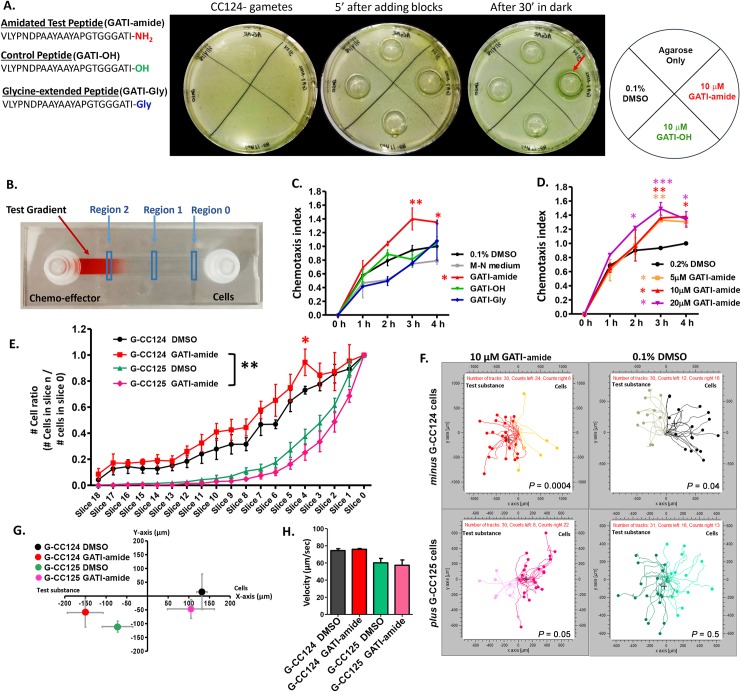
GATI-amide acts as a chemotactic modulator for C. reinhardtii gametes.A. Agarose block assay. CC124 minus gametes were uniformly spread on the surface of a Petri dish containing 1% agar in M-N medium. Agarose blocks containing 10 μM GATI-amide, 10 μM GATI-OH, M-N medium, or M-N medium containing 0.1% DMSO were placed onto the Petri dish; after 30 minutes in the dark, minus gametes had accumulated around the agarose block containing GATI-amide (red arrow). Similar results were obtained in three independent experiments. B. Microfluidic chemotaxis assay. Microfluidic channel slides were used for chemoattractant gradient formation. An image of a gradient of red food dye is shown. For each treatment, the number of cells in regions 0, I, and 2 were counted over time. C. Chemotaxis assay of minus gametes in microchannel slide. The chemotaxis index (CI) was measured over a period of 4 hours in response to 10 μM GATI-amide, GATI-OH, GATI-Gly, M-N medium, and vehicle control. The CI in the presence of GATI-amide was significantly higher at 3 hours (**P < 0.01) and 4 hours (*P < 0.05) compared to 0.1% DMSO. D. Dose dependence of the response of minus gametes to GATI-amide. A 4-hour incubation period was used; 0.2% DMSO was used as the vehicle control to accommodate the use of 20 μM peptide. The CI of 5 μM GATI-amide was significantly higher than the control at 3 hours (**P < 0.01); for 10 μM GATI-amide, the CI was significantly higher at 3 hours (**P < 0.01) and 4 hours (*P < 0.05), while for 20 μM GATI-amide it was significantly higher at 2 hours (*P < 0.05), 3 hours (***P < 0.01), and 4 hours (*P < 0.05). The only CI to ever exceed 1.00 was for GATI-amide. E. Chemotactic response. The response of minus and plus gametes to 10 μM GATI-amide and 0.1% DMSO. The number of cells for each treatment was counted along the entire channel length, and the ratio of the number of cells in each slice/number of cells in slice 0 (nslice X/nslice 0) was plotted for the 4-hour time point. The response of gametic CC124 cells to GATI-amide was significantly (**P < 0.001) different from gametic CC125 cells. Data are the average of three independent experiments ± SEM. F. Trajectory plots. Plots are shown for minus and plus gametes. Data are representative of three independent experiments; all plots shown are from one experiment. G. Population response. The center of mass was calculated for each population from trajectory plots like those shown in F. Results are the average of three independent experiments ± SEM. H. Motile behavior. The swimming velocities of minus and plus gametes were not altered by the presence of the amidated peptide. Results are the average of three independent experiments ± SEM. One-way and two-way ANOVAs were used as appropriate. The underlying numeric data for this figure can be found in S1 Data. GATI-amide, VLYPNDPAAYAAYAPGTGGGATI-amide; M-N medium, gametic medium.